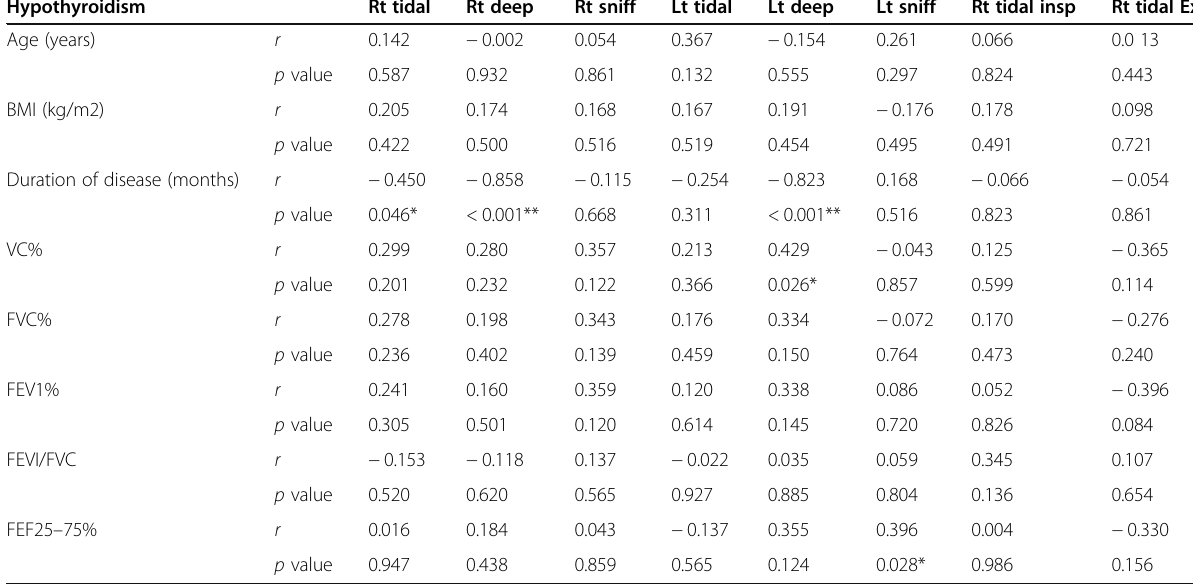
Table 5 Correlation between diaphragmatic excursion and diaphragmatic thickness with demographic data, duration of disease, and pulmonary functions test in hypothyroidism group